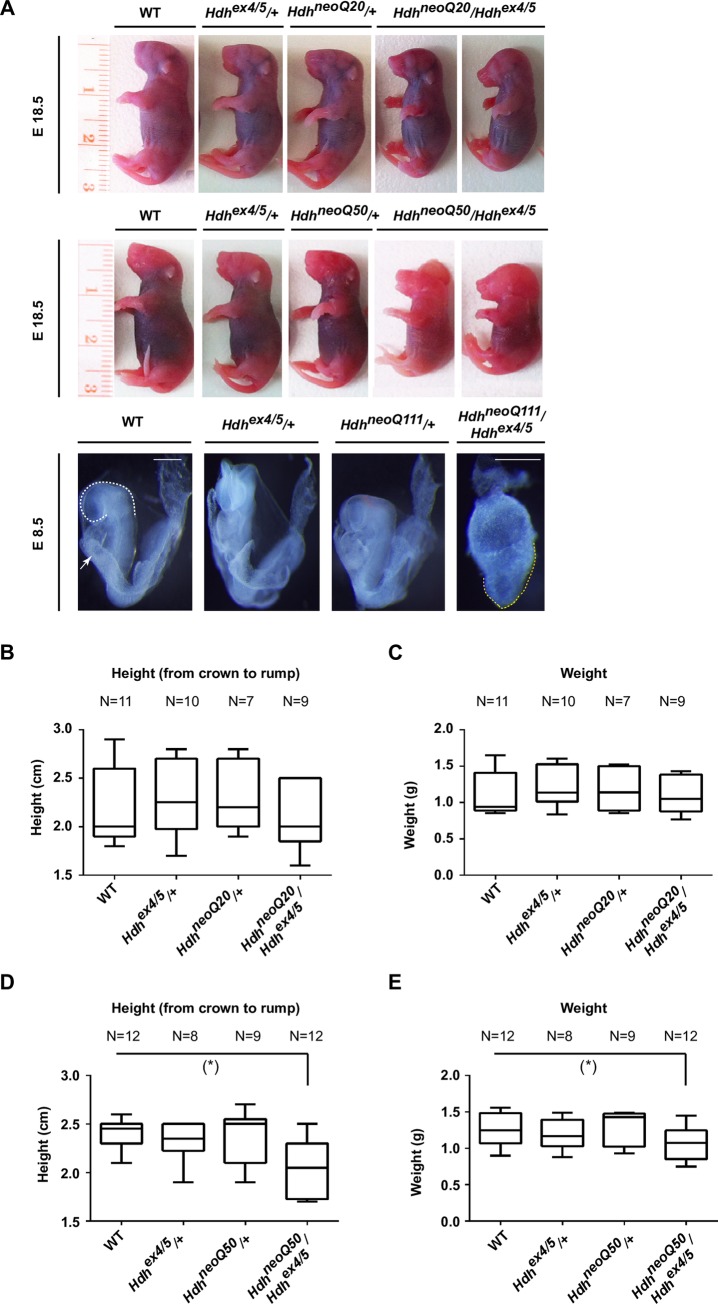
HdhneoQ20/Hdhex4/5, HdhneoQ50/Hdhex4/5 and HdhneoQ111/Hdhex4/5 hypomorphic embryos.A) Representative pictures of wild-type (WT), Hdhex4/5/+, HdhneoQ20/+, HdhneoQ50/+, HdhneoQ111/+, HdhneoQ20/Hdhex4/5, HdhneoQ50/Hdhex4/5 and HdhneoQ111/Hdhex4/5 embryos. The size and the shape of embryos with different genotypes is shown at E18.5 for animals generated by crossing HdhneoQ20/+ with Hdhex4/5/+ mice and HdhneoQ50/+ with Hdhex4/5/+ mice. For embryos generated by crossing HdhneoQ111/+ with Hdhex4/5/+ mice, representative pictures were taken at E 8.5. Dashed white line in the WT image outlines the rostral part of the forebrain headfolds and the white arrow points to the heart. The yellow dashed lines in the HdhneoQ111/Hdhex4/5 images depict anterior endoderm in the late stage streak embryo, typical of a mouse developmental stage of E7.5. Scale bar = 300μm. Tables 1–3 summarizes the appearances of all embryos analyzed and the penetrance of the phenotypes. B-C) Box-and-whisker graphs show quartiles of height in cm (cm) and weight in grams (g) of different genotypic groups of animals generated by crossing HdhneoQ20/+ with Hdhex4/5/+ mice. The median is indicated and whiskers indicate 1.5XIQR. The number (N) of animals for each group is indicated above. Error bars represent standard deviations from the mean. D-E) Box-and-whisker graphs show quartiles of height in cm (cm) and weight in grams (g) of different genotypic groups of animals generated by crossing HdhneoQ50/+ with Hdhex4/5/+ mice. The median is indicated and whiskers indicate 1.5XIQR. The number (N) of animals for each group is indicated above. A significant reduction in size of HdhneoQ50/Hdhex4/5 embryos is noted. P value < 0.05 (*). Error bars represent standard deviations from the mean.